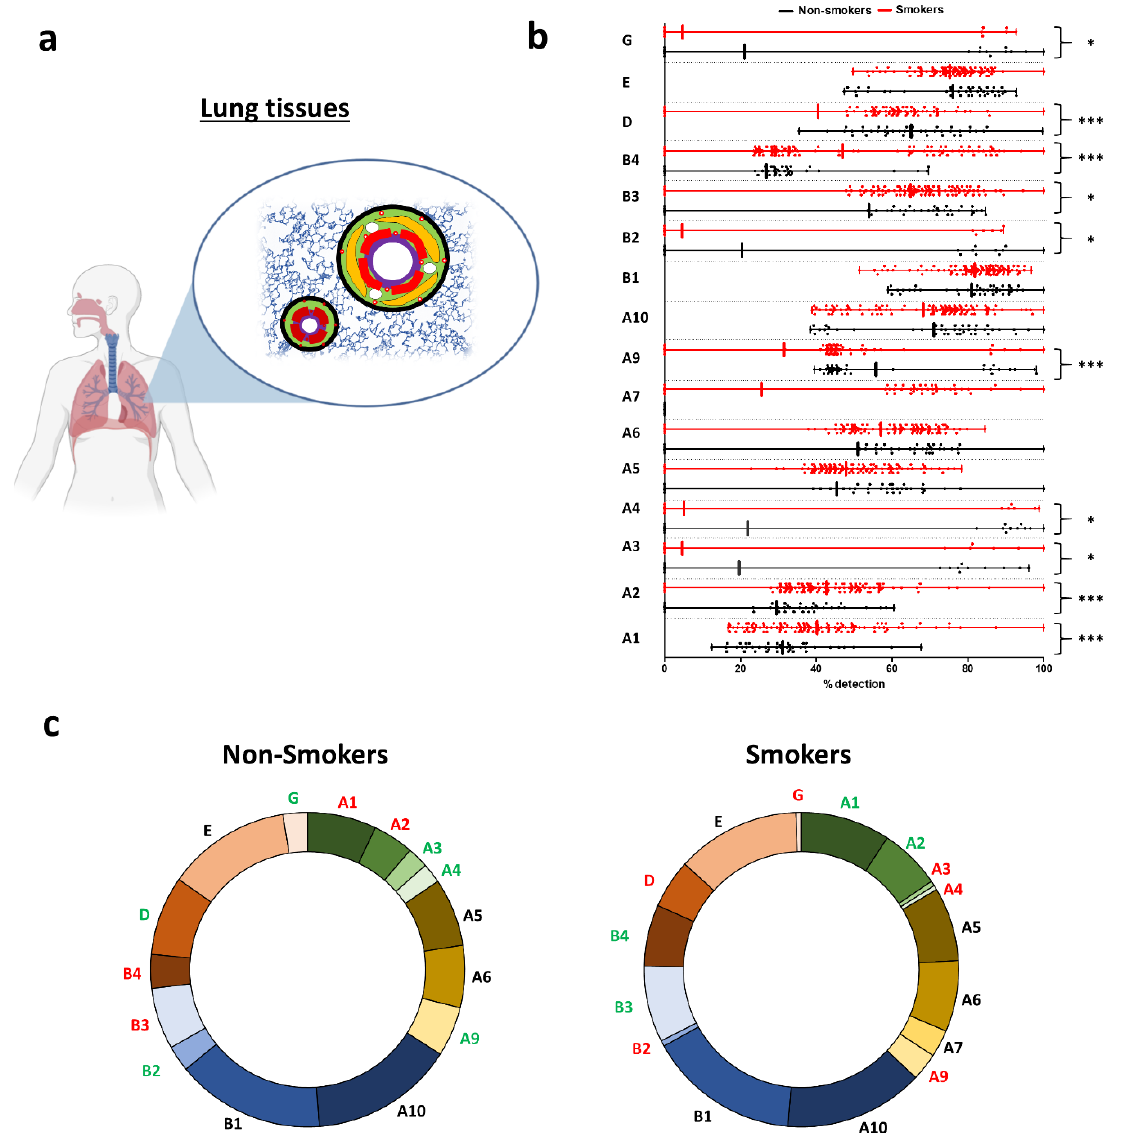
Figure 1. Evaluation of nicotinic acetylcholine receptor (nAChR) transcript levels in human lung tissues. ( a ) Illustration depicting the origin of the samples. Whole-lung tissues contained all the tissues present in the lung either in parenchyma or in / around bronchi and bronchioles. ( b ) Histogram showing the detection of nAChRs in non-smokers (black) and smokers (red). * p < 0.05; *** p < 0.001 non-smokers ( n = 42) vs. smokers ( n = 111). ( c ) Pie charts showing the repartition of nAChRs in non-smokers (left) and smokers (right). Coloured subunits indicate upregulation (green) and downregulation (red) in both groups when statistically significant.